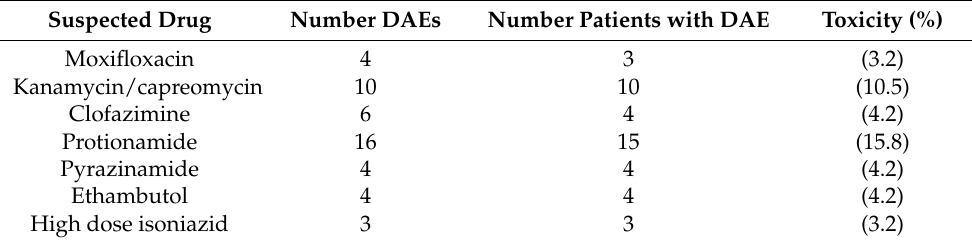
Table 4. Management and outcome of DAEs among RR-TB patients enrolled in shorter treatment regimens in Tashkent.